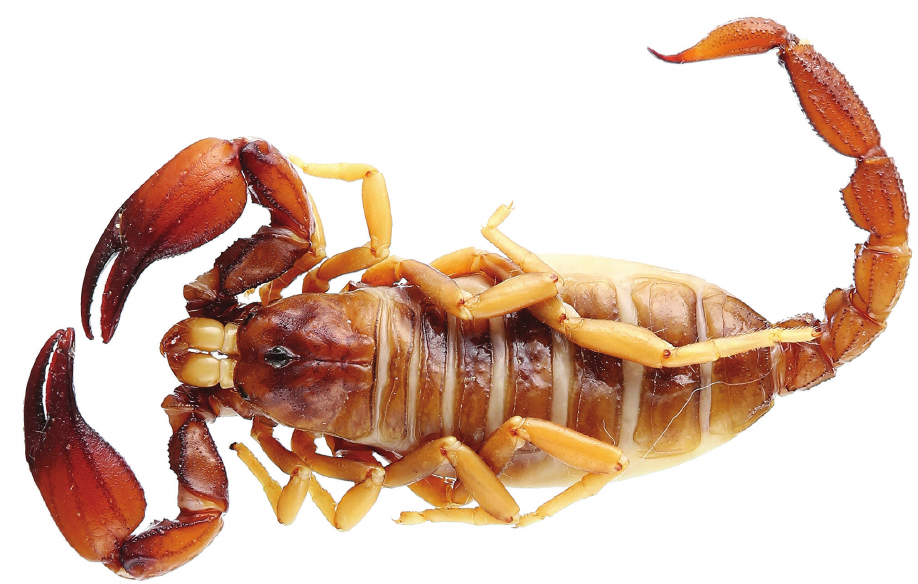
Figure 26. Guyanochactas gonzalezspongai , male holotype from Antecume-Pata (photograph MNHN / E.-A.